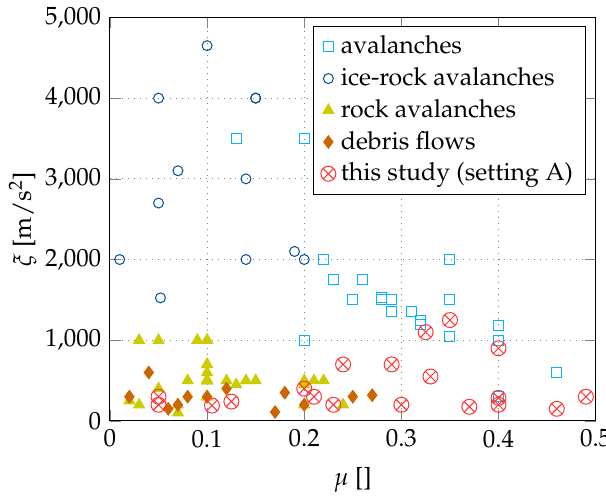
Figure 4. Friction parameters µ and ξ from back-calculation of different events with RAMMS DF. Avalanche data are from Christen et al. [28], Bartelt et al. [36], Barbolini et al. [47]. Ice-rock